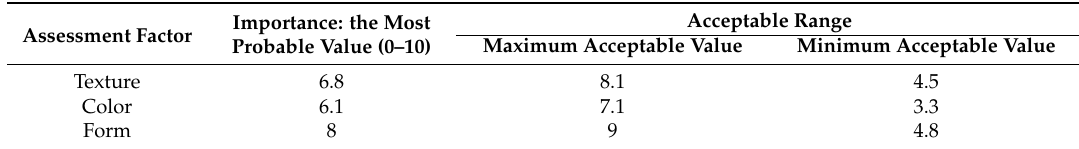
Table 3. Importance of assessment factors on the landscape aesthetics consideration of a check